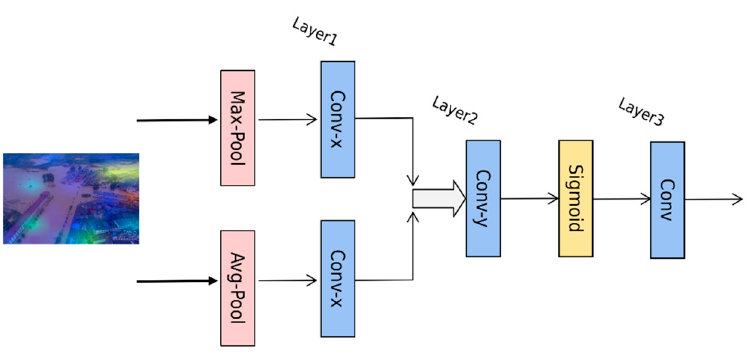
Figure 1. Algorithm structure diagram of spatial attention mechanism.